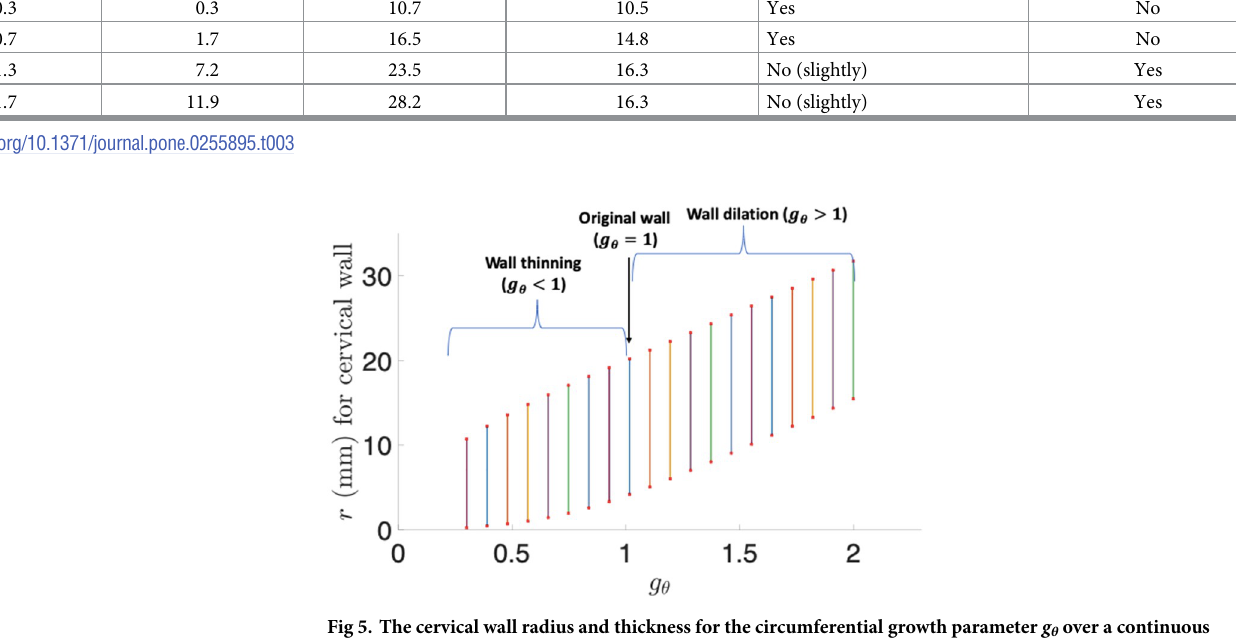
Table 3. Cervical wall thinning/thickening and dilation results for different circumferential growth parameters g θ under g r = g z = 1. Length unit: mm. g θ